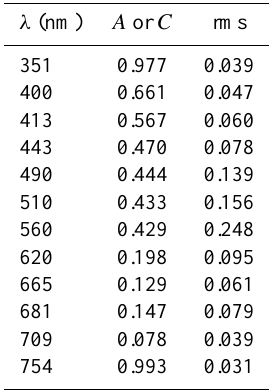
Table 3. Best-fit values of A in the range 400–709nm, of C at 351 and 754nm, and the rms deviations between these values and indi- vidual calculations of A and C at the wavelengths λ . λ (nm) A or C